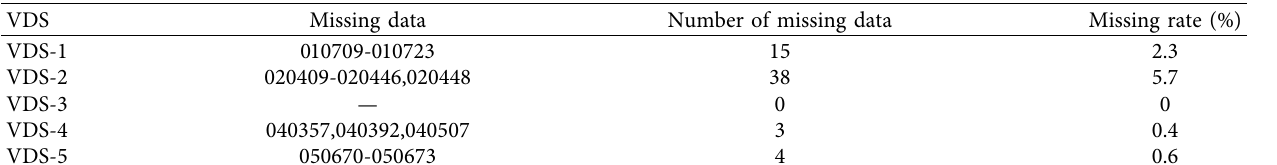
Table 4: Data fragmentation.